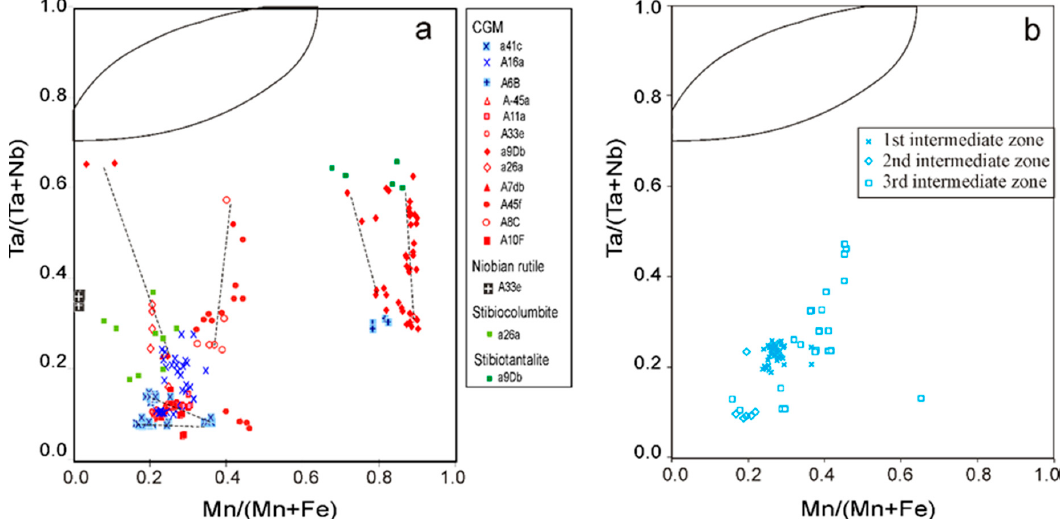
Figure 18. Composition of the Nb-Ta rich minerals plotted in the columbite quadrilateral (atomic ratios) of ( a ) type IV pegmatites; blue, first intermediate zone and red, second intermediate zone; ( b ) type-V pegmatites. Dashed lines represent the composition of different areas in the same crystal.